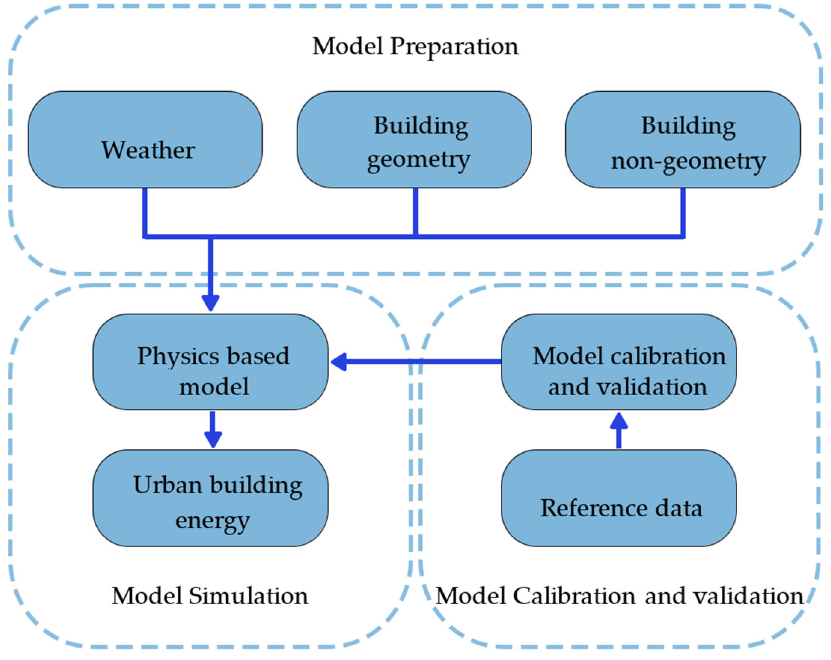
Figure 1. Flowchart of urban building energy modelling using the physics-based bottom model (based on [2]).